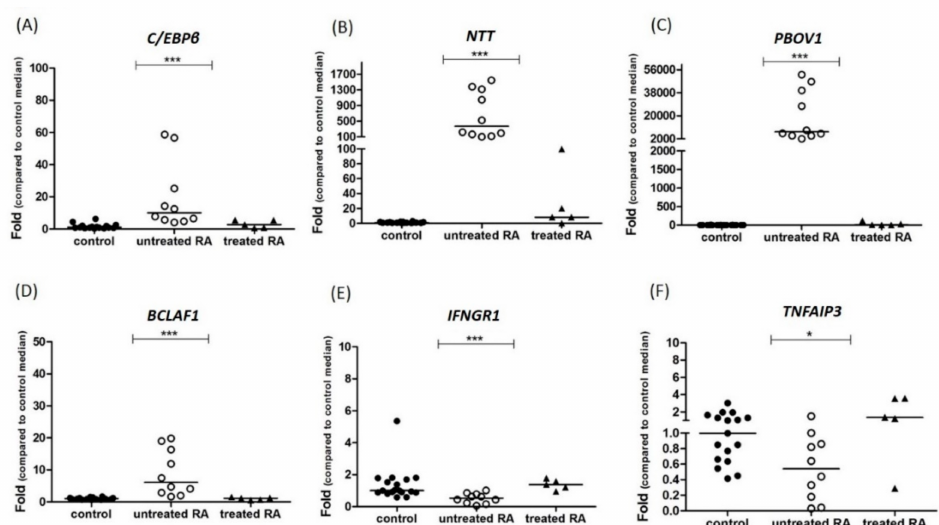
Figure 3. C/EBP β /NTT/PBOV1 expression levels are elevated in peripheral blood mononuclear cells (PBMCs) of untreated rheumatoid arthritis (RA) patients. RNA expression levels of ( A ) C/EBP β , ( B ) NTT , ( C ) PBOV1 , ( D ) BCLAF1 , ( E ) IFNGR1 and ( F ) TNFAIP3 in PBMCs derived from healthy controls ( n = 17), untreated RA patients ( n = 10), and treated RA patients ( n = 5, blood drawn after 2 years of follow-up). Lines represent medians; * p < 0.05, *** p < 0.0001 by Kruskal–Wallis tests. RNA expression levels are shown as folds compared with median levels of healthy